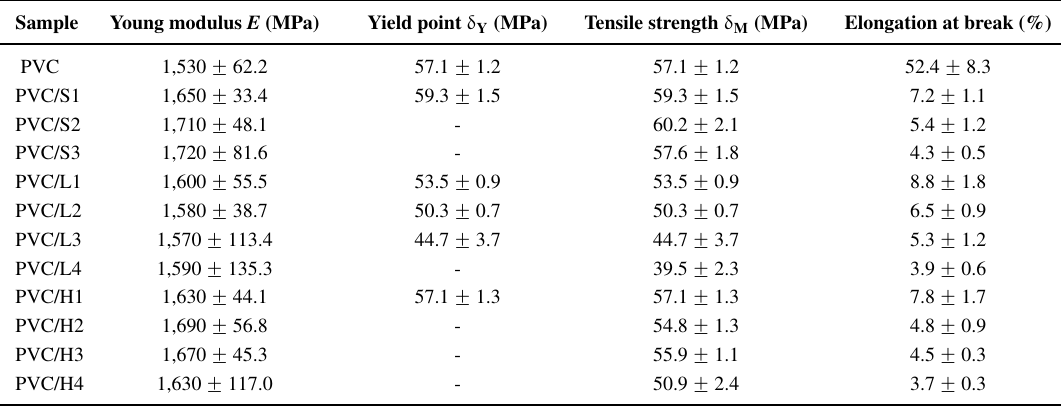
Table 4. Mechanical properties of the tested materials.